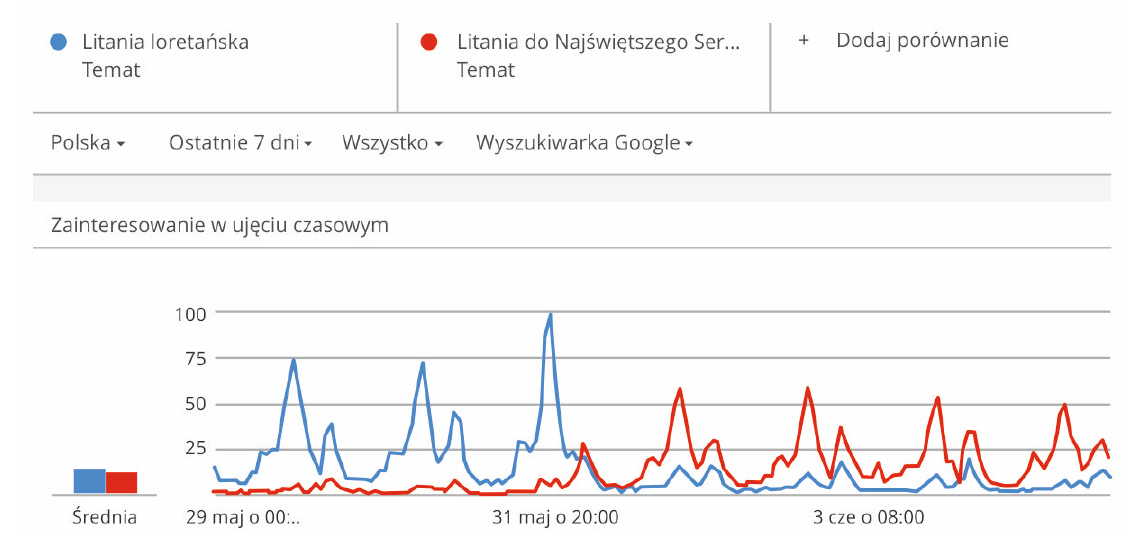
Figure 7. Search frequency for the keywords “Litany of Loreto” and “Litany of the Sacred Heart of Jesus” (Polish: “ Litania do Naj ś wi ę tszego Serca Pana Jezusa ”) in May/June 2021; source: Google Trends, https://www.google.com/trends (accessed on 4 June 2021).